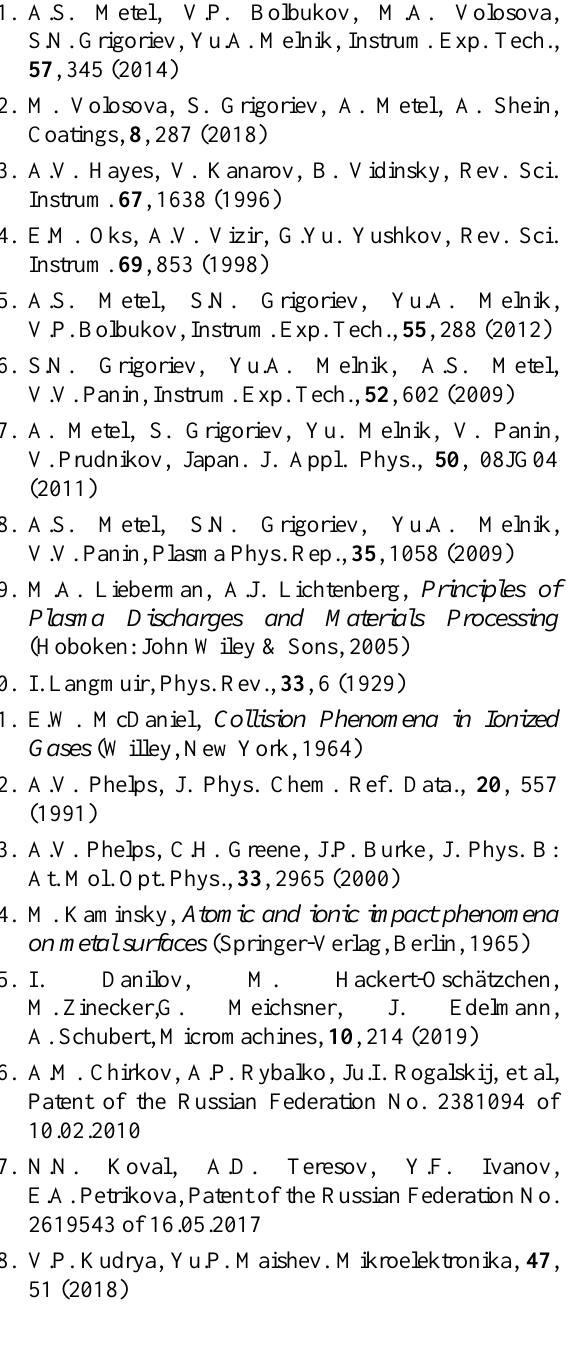
Fig. 6. The dependence of the beam diameter D on the distance Z between the grid and the